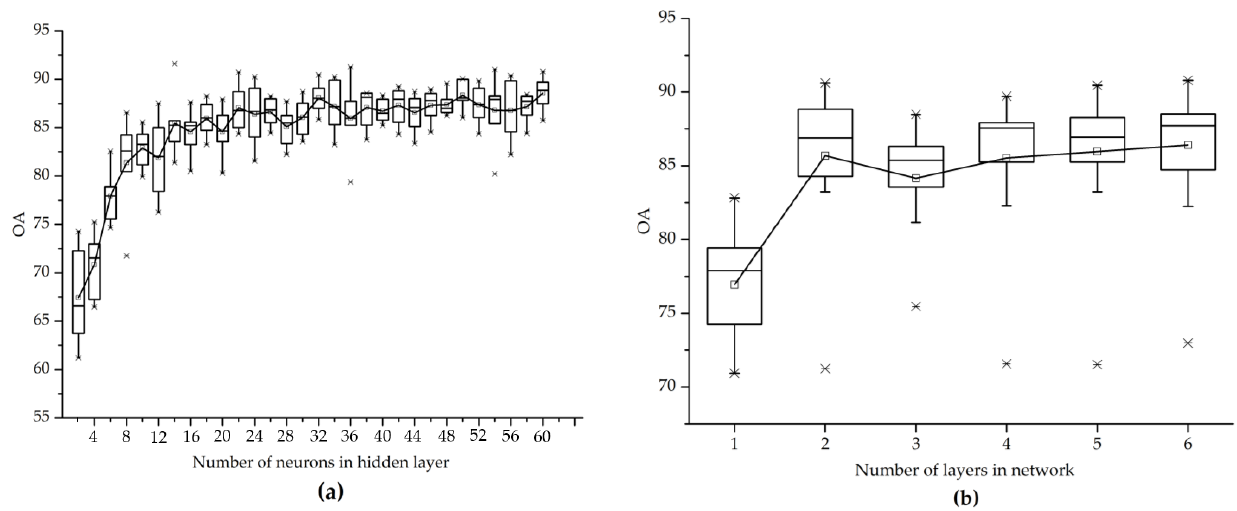
Figure 11. ( a ) The relationship between classification performance and the number of hidden layer neurons. ( b ) The relationship between classification performance and the number of layers in the network.